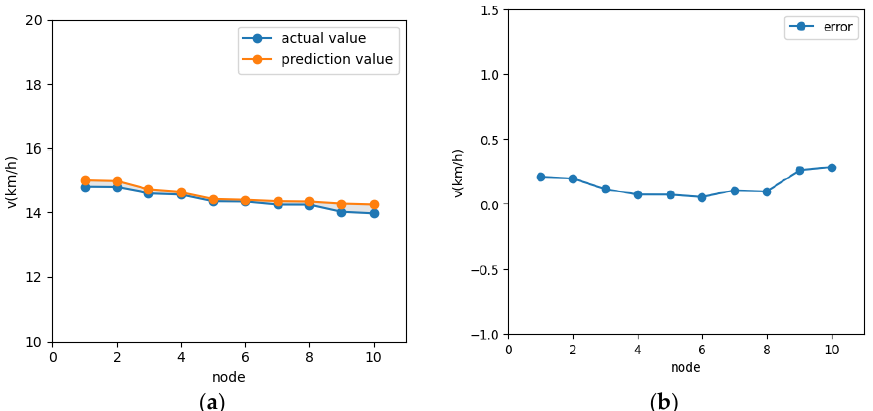
Figure 13. Congestion Scenarios prediction speed: ( a ) actual speed vs. predicted speed; ( b ) prediction speed